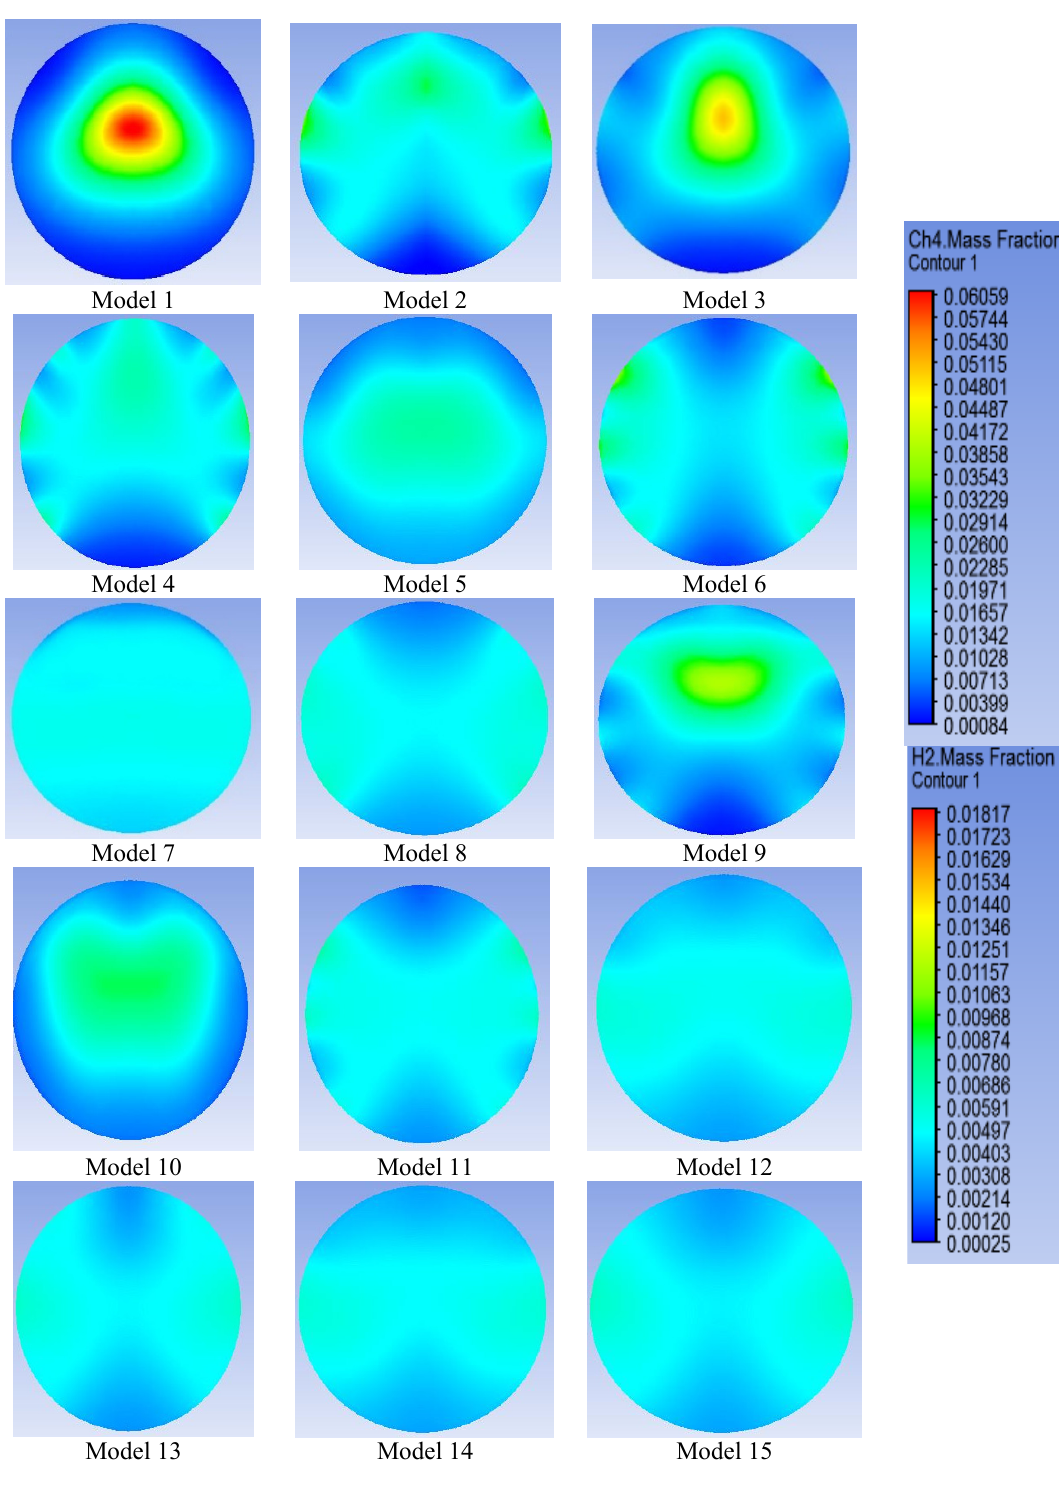
Figure 17. Local methane mass fraction contour at outlet of the existing mixer and new mixer models (best case for each model) under Air-HCNG ratio 51.315.